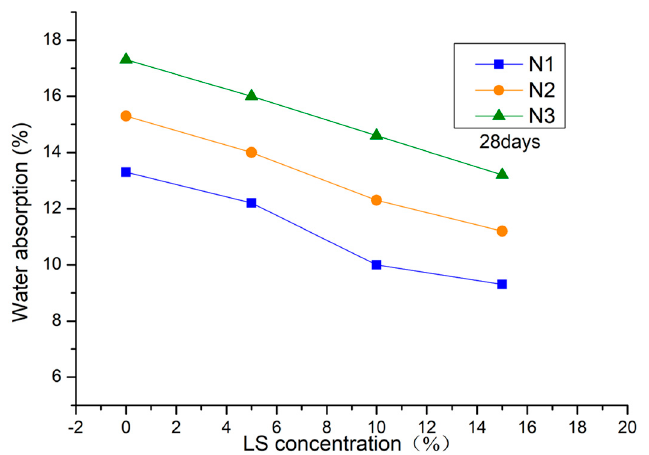
Figure 7. Effect of LS on water absorption of NHL-based mortar. Figure 7. E ff ect of LS on water absorption of NHL-based